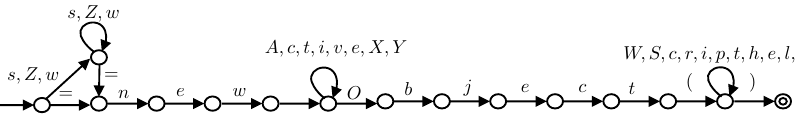
Figure 16. A d abstract value of d before eval call of the program in Figure